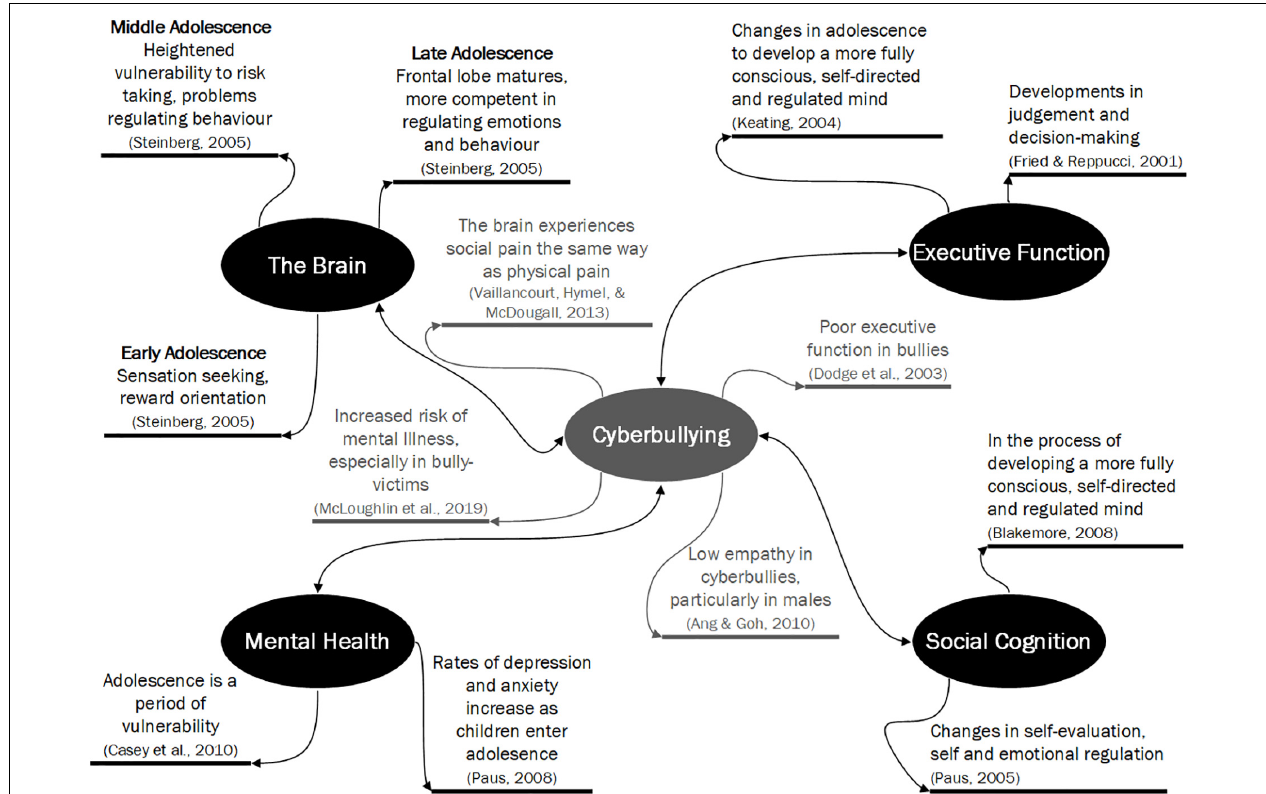
FIGURE 1 | Changes in the brain and cognition occurring during adolescence which may influence cyberbullying behaviors. Black text represents changes and patterns to the brain and to cognition that occur during adolescence. The gray text represents aspects of cyberbullying associated with each of these four major factors discussed throughout this article. Furthermore, the associations between each factor and cyberbullying are represented as bi-directional in the figure, however, further research (in particular, longitudinal) needs to determine the nature and direction of relationships. Please note that all factors are significantly influenced by age and gender, as discussed throughout the article, however, these are not outlined in detail here for ease of interpretation of the